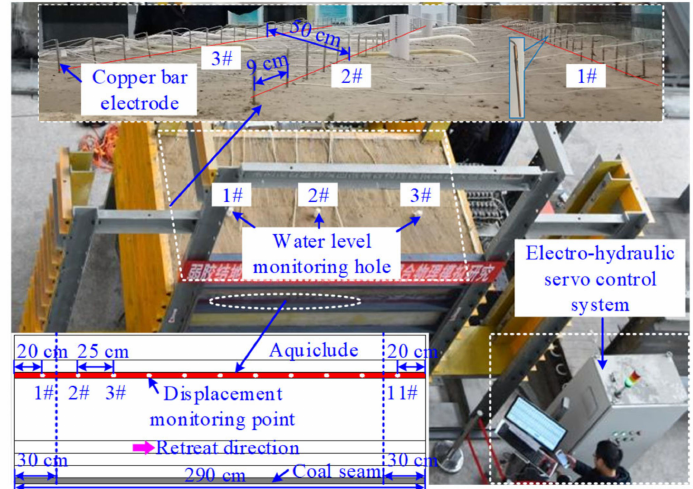
Figure 3. Measurement